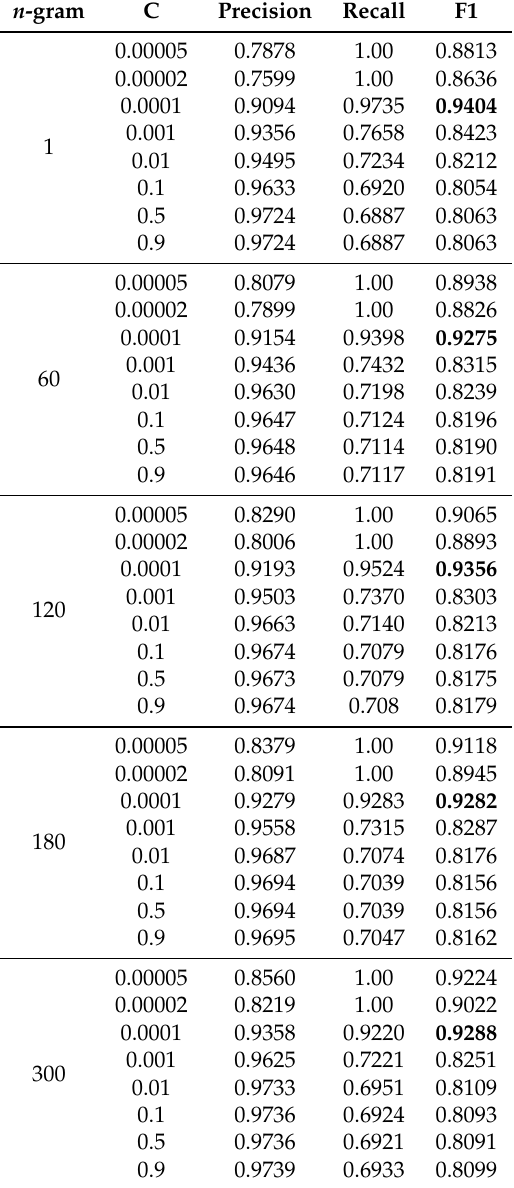
Table 3. Precision, Recall, F1-score of different grams on SVDD algorithm. Best performance of the F1-score is highlighted in bold. n -gram C Precision